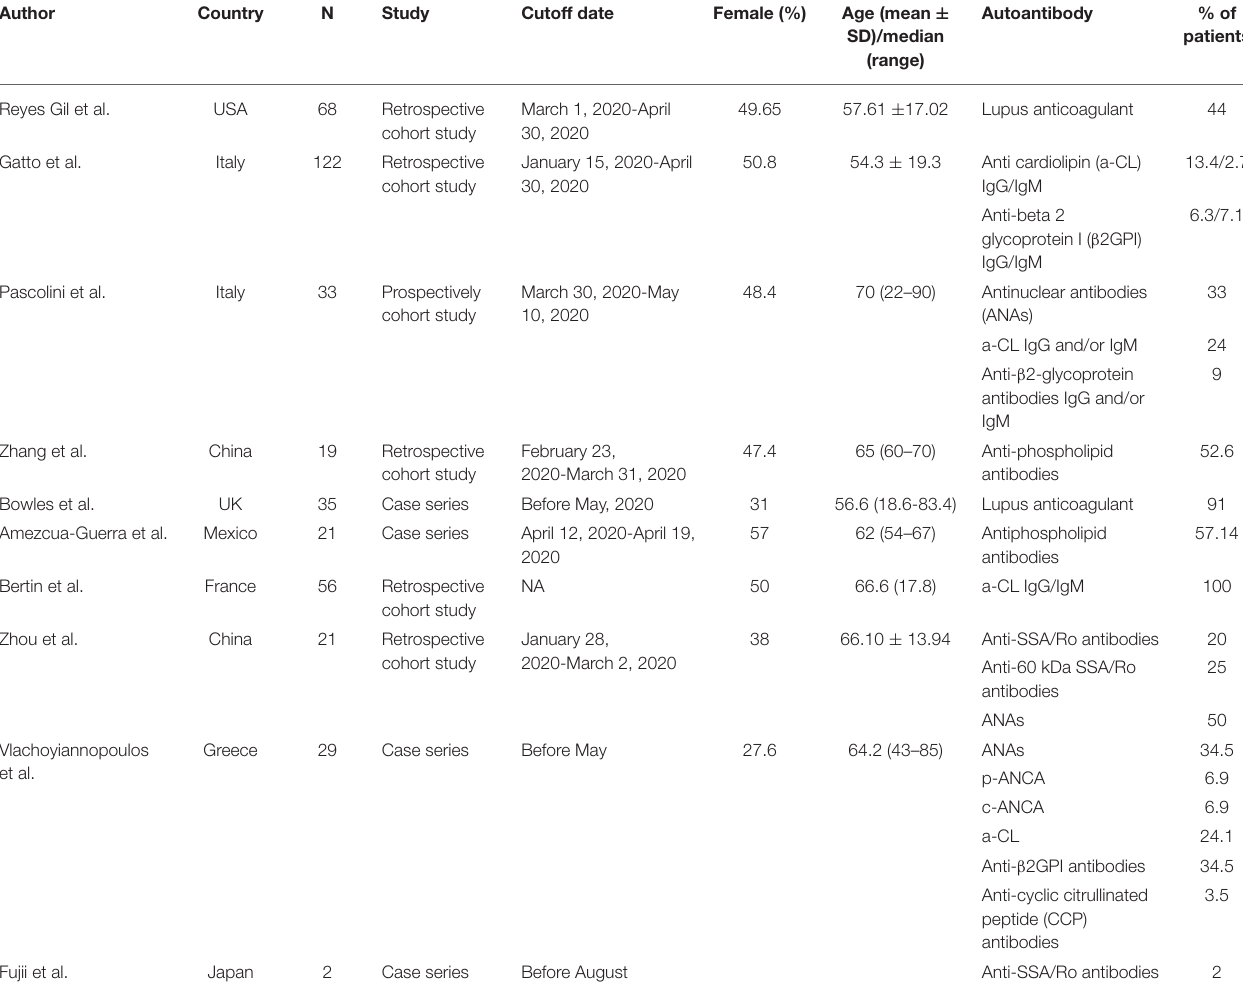
TABLE 4 | Autoantibodies are present in patients with non-rheumatic diseases infected with